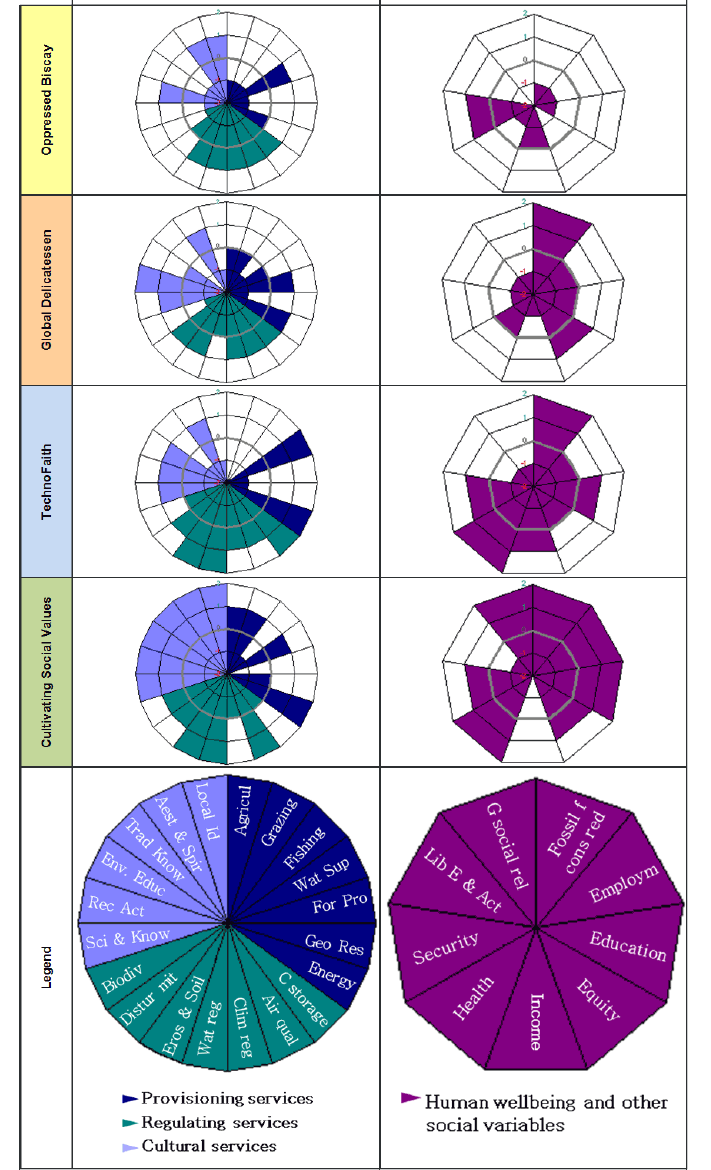
Fig. 3 . Provision of ecosystem services and indicators of human well-being under each scenario, compared to the current conditions (substantial increase = 2; increase = 1; constant or increases in same aspects and decreases in other aspects = 0; decrease = 1; large decrease = 2). Name codes: Sci & Know = Science & Knowledge; Rec Act = Recreational activities; Env Educ = Environmental education; Trad Know = Traditional knowledge; Aest & Spir = Aesthetic and spiritual values; Local Id = Local identity; Agricul = Agriculture; Wat Sup = Water supply; For Pro = Forest products; Geo Res = Geological resources; C storage = Carbon storage; Air qual = Air quality; Clim reg = Climate regulation; Wat reg = Water regulation; Eros & Soil = Erosion control & soil fertility; Distur mit = disturbance mitigation; Biodiv = Biodiversity; Lib E & Act = Liberty of election and action; G social rel = Good social relations; Fossil f cons red = Fossil fuel consumption reduction; Employm = Employment. In some cases, as in the case of security in the Oppressed Biscay scenario, increases are not linked to social positive aspects, and decreases are not always negative (e.g., in the Cultivating Social Values scenario, liberty is closely related to responsibility and consumption is limited, so the accepted definition of liberty is